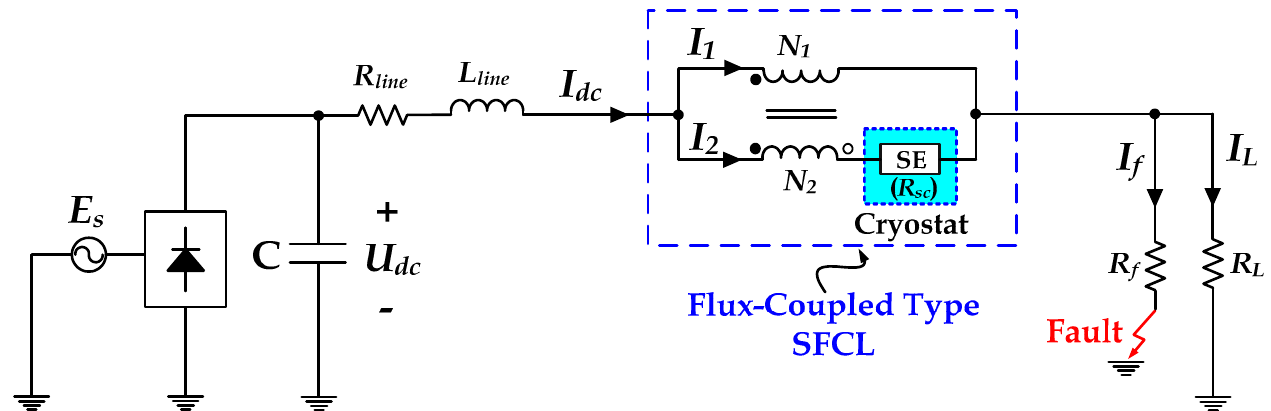
Figure 1. Schematic diagram of flux-coupled type superconducting fault current limiter (SFCL) in DC side poles short circuit error.